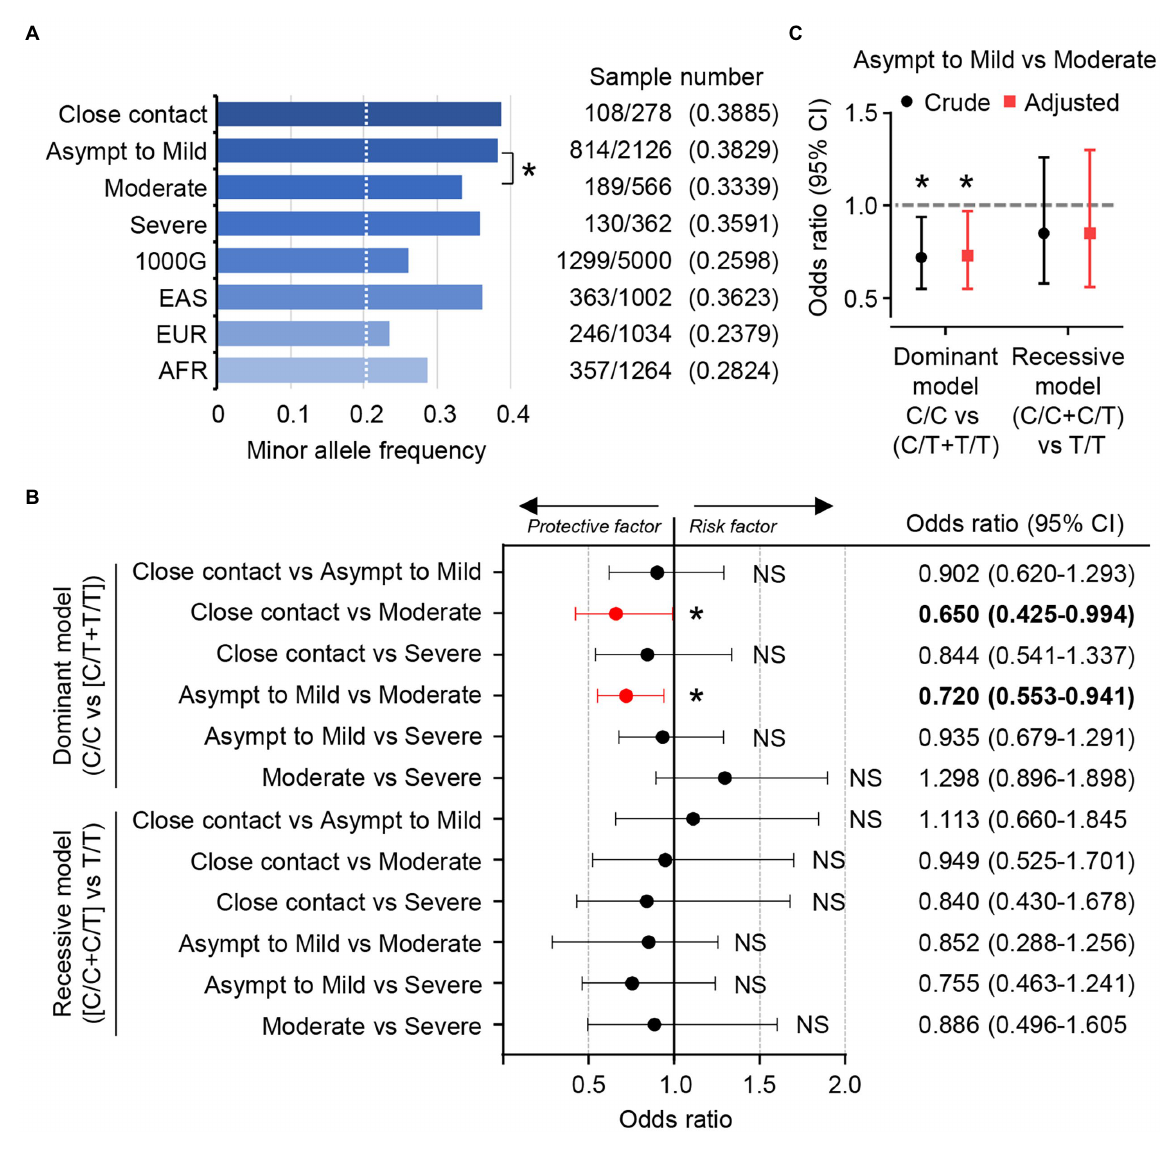
FIGURE 2 rs12329760 in the TMPRSS2 gene is associated with susceptibility to SARS-CoV-2. (A) Minor allele frequency for rs12329760 from this study and the 1000 Genomes database. 1000G, all populations in the database; EAS, East Asian; EUR, European; AFR, African. * p < 0.05, ** p < 0.01;